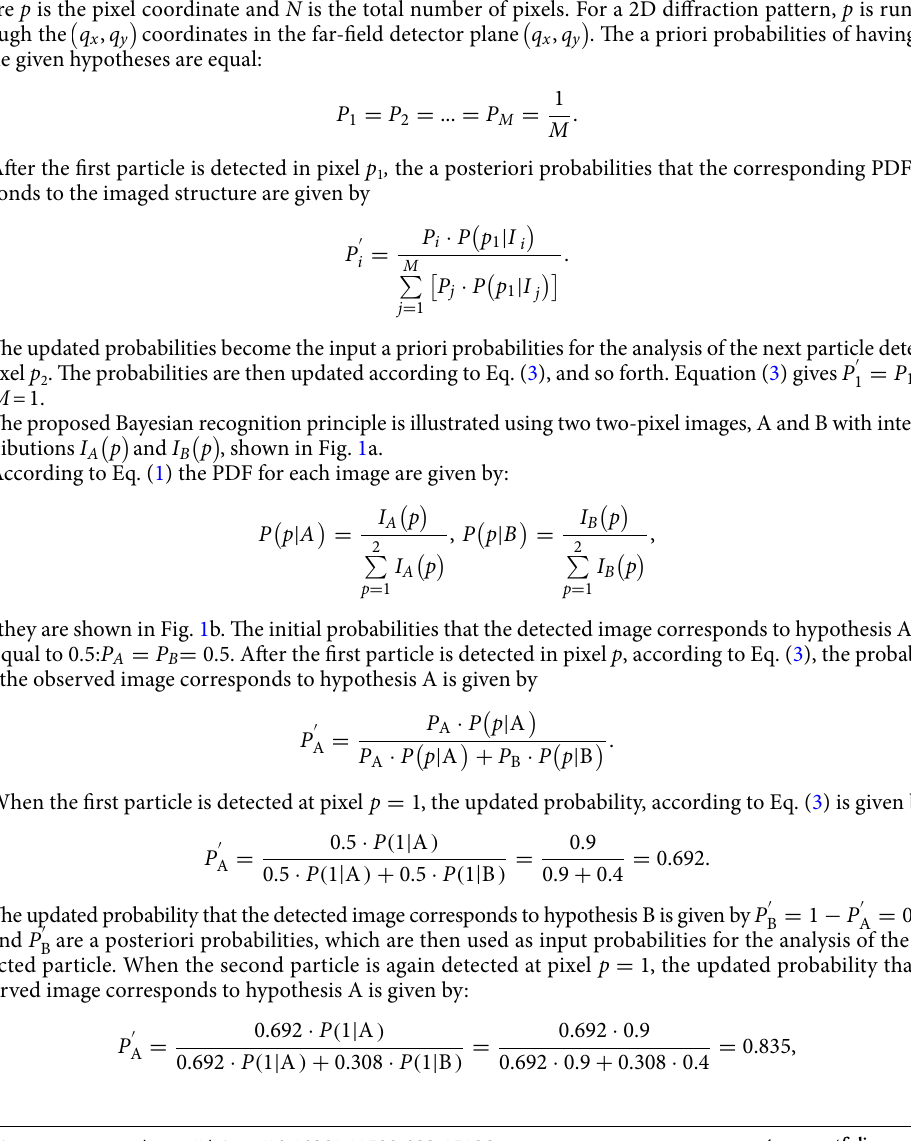
coordinates in the far-field detector plane